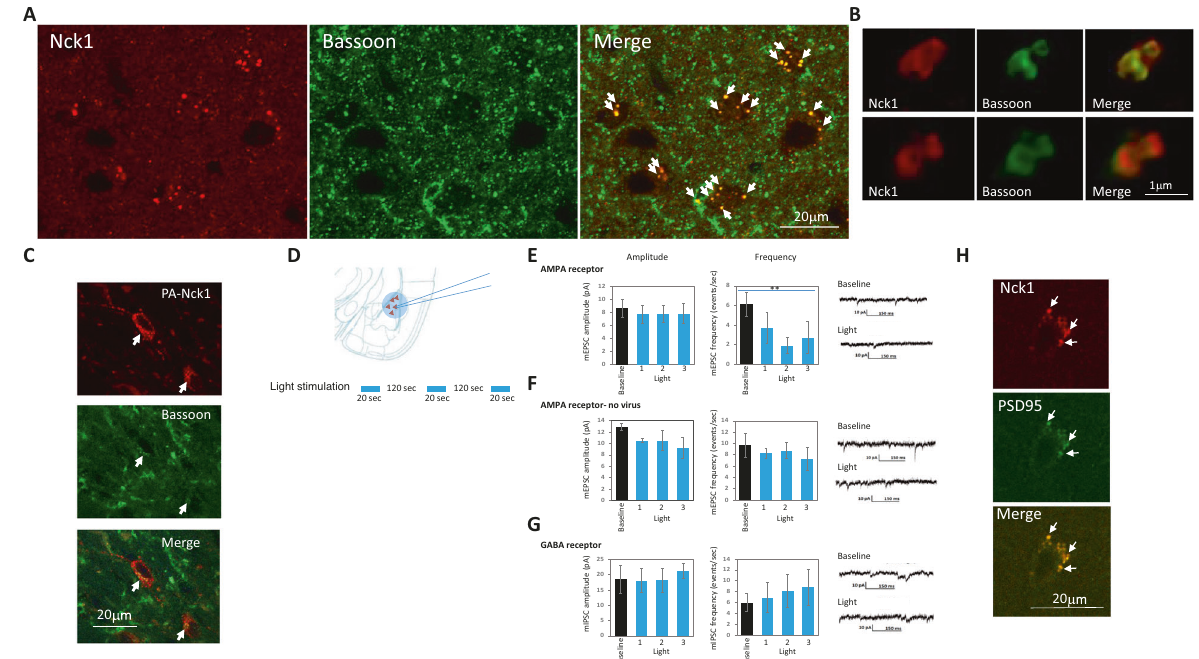
Fig. 4 Nck1 is localized to presynapses in LA and its activation decreases the frequency of AMPAR-mediated mEPSCs. A Lateral amygdala neurons were co-labeled with antibodies that bind to Nck1 and Bassoon (a presynaptic protein). Nck1 is colocalized with bassoon in presynapse. B Super-resolution microscopy reveals that Nck1 localization is almost perfectly aligned with Bassoon in presynapse. C PA-Nck1 is co-localized with Bassoon. Arrows show PA-Nck1, Bassoon and the colocalized PA-Nck1 and Bassoon. D Schematic description of the voltage patch-clamp preparation and mode of light stimulation. E AMPAR-mediated mEPSCs amplitude and frequency before lights stimulation (Baseline; black) and during the 3 light stimuli (blue) are shown. No signi fi cant differences in amplitude between the baseline and light stimuli were detected ( F (3,9) = 1.145, p = 0.382). Signi fi cant differences were detected in frequencies of mEPSCs between the baseline and light stimuli ( F (3,9) = 6.642, p = 0.012; n = 4). F Shining light alone on the lateral amygdala that does not express PA-Nck1 does not affect AMPA-mediated mEPSCs ( n = 3) amplitude ( F (1.181,2.362) = 2.351, p = 0.254) and frequency ( F (1.089,2.178) = 0.804, p = 0.47). G GABAR-mediated mIPSCs amplitude and frequency before lights stimulation (Baseline; black) and during the 3 light stimuli (blue). No signi fi cant differences were detected ( n = 4) (amplitude- F (3,9) = 0.705, p = 0.573; frequency- F (3,9) = 0.923, p = 0.468). Representative event traces of AMPAR-mediated mEPSCs and GABAR- mediated mIPSCs from neurons recorded in the LA are shown. H Lateral amygdala neurons were co-labeled with antibodies that bind to Nck1 and PSD-95. Nck1 is colocalized with PSD-95. Arrows show Nck1, PSD-95 and the colocalized Nck1 and PSD-95. Values are mean ± SEM. E – G Repeated measure ANOVA with LSD post hoc LA enhanced long-term, but not short-term, auditory fear conditioning memory. This result shows that Nck1 restricts neuronal processes that are needed for the consolidation of long-term memory. Activation of PA-Nck1 by light in LA during fear conditioning training impaired long-term, but not short-term, auditory fear conditioning memory. These observations show that the increase of Nck1 activity during training does not affect auditory fear memory acquisition but rather its consolidation into long-term memory. Thus, Nck1 serves to modulate the ability of amygdala neurons to form long-term memory. We also found that activation of Nck1 in LA during fear conditioning training, but not immediately afterward, impairs long-term auditory fear conditioning memory. This observation implies that Nck1 activity in LA may restrict the formation of long- term fear memory by affecting synaptic transmission. This assumption was further strengthened by our fi nding that Nck1 is localized to the presynapse. We, therefore, examined the effect of Nck1 activity on AMPA receptor-mediated mEPSCs or GABA receptor-mediated mIPSCs. We found that activation of PA-Nck1 in LA led to a decrease in the frequency of AMPAR-mediated mEPSCs. GABAR-mediated mIPSCs were not affected by the activation. The reduction in mEPSCs frequency indicates a decrease in the probability of synaptic glutamate release [37]. Thus, Nck1 activation restricts glutamate release an event that affects fear memory formation. For example, it was shown that AMPA receptors are essential for fear memory formation [38].